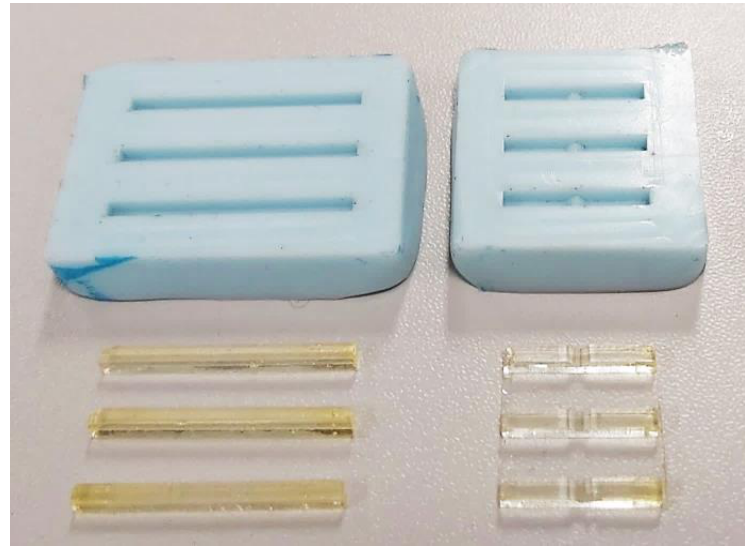
Figure 1. Molds and manufactured samples.